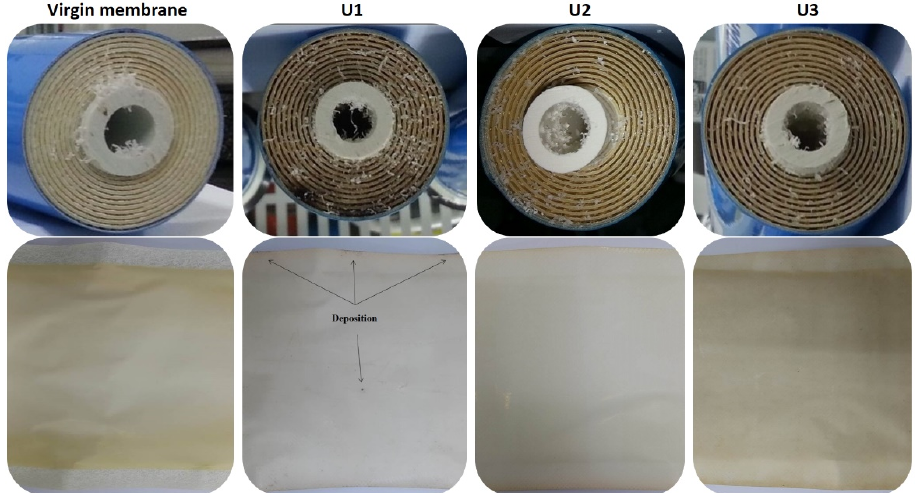
Figure 3. The visual examination of membranes (( top ): inlet cross-section; ( bottom ): unfolded membrane surfaces) used in this study.